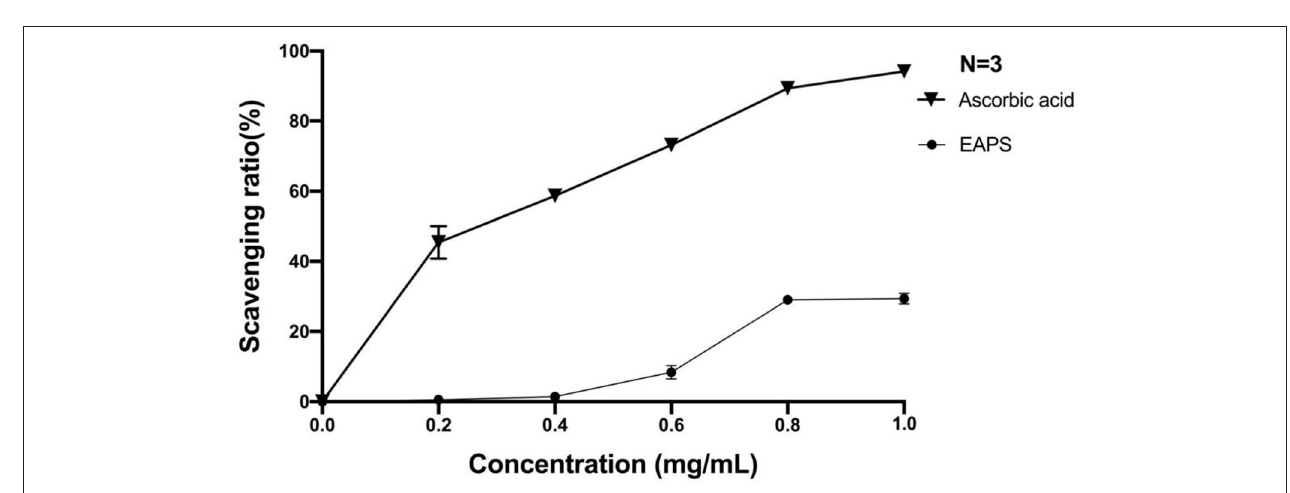
FIGURE 5 | Scavenging effects of EAPS on superoxide anion